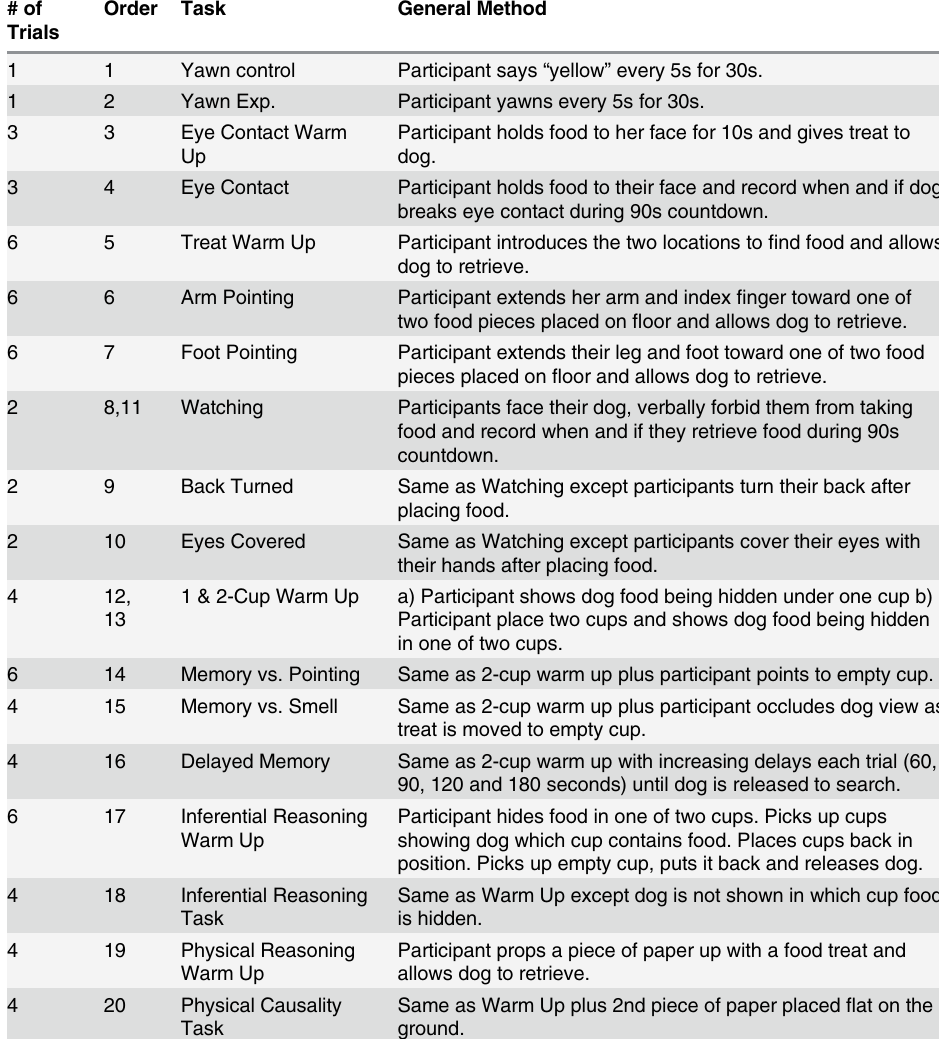
Table 2. The numbers of trials, the order tasks are presented to all participants, task names and gen- eral methods. For more details see supplemental methods. # of